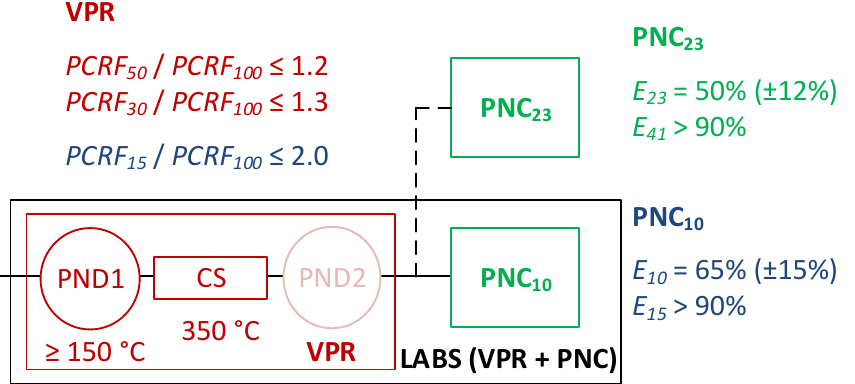
Figure 1. Schematic of a typical particle number system (LABS = VPR + PNC in black box) consisting of a VPR (red box) and a PNC (green box). At the top of the figure the main calibration requirements are given for the 23 nm systems; the requirements for the 10 nm systems are shown in blue. E = counting efficiency; PCRF = particle concentration reduction factor; PNC = particle number counter; PND = particle number diluter; CS = catalytic stripper; VPR = volatile particle remover.